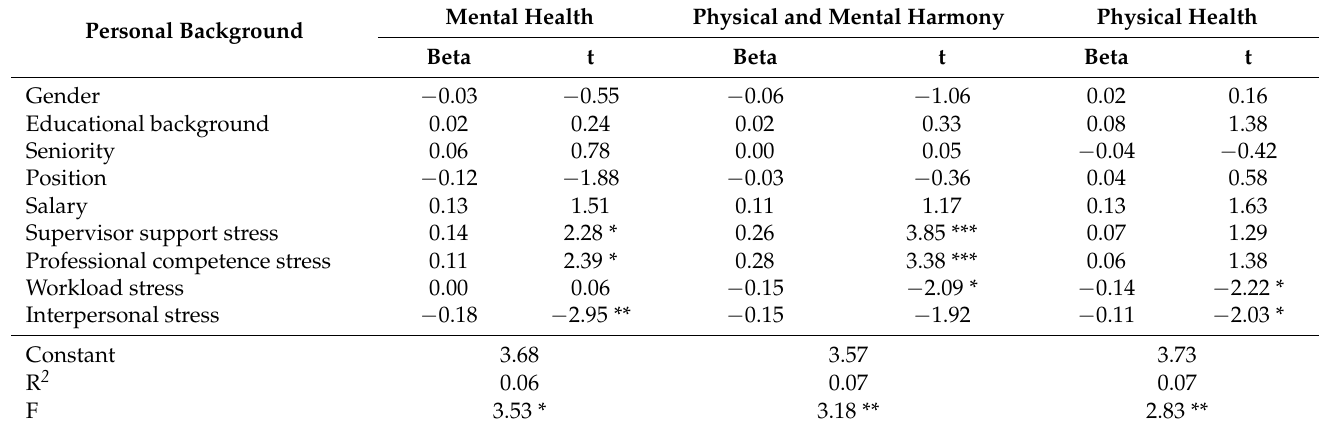
Table 6. Multiple regression analysis of wellness, personal background factors, and job